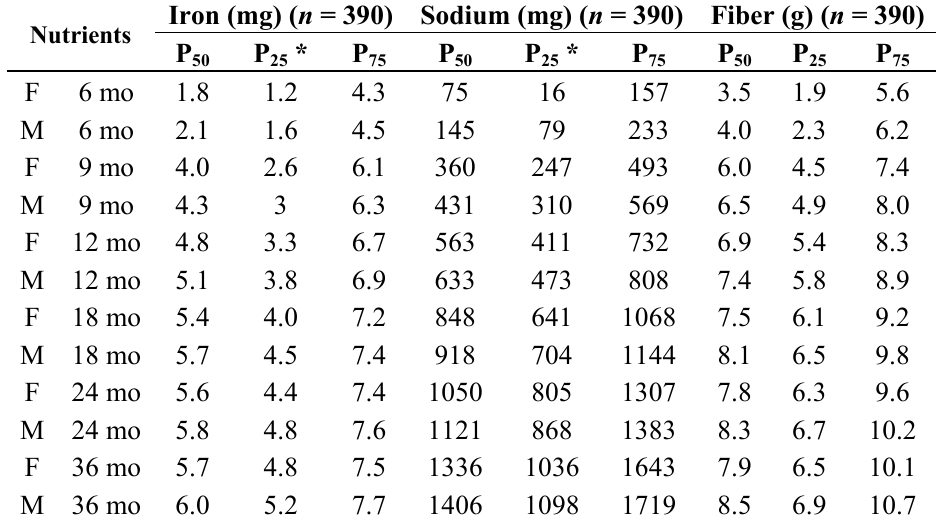
Table 7. Percentiles of iron, sodium and fiber intake in the pooled sample of NI636 children. Nutrients